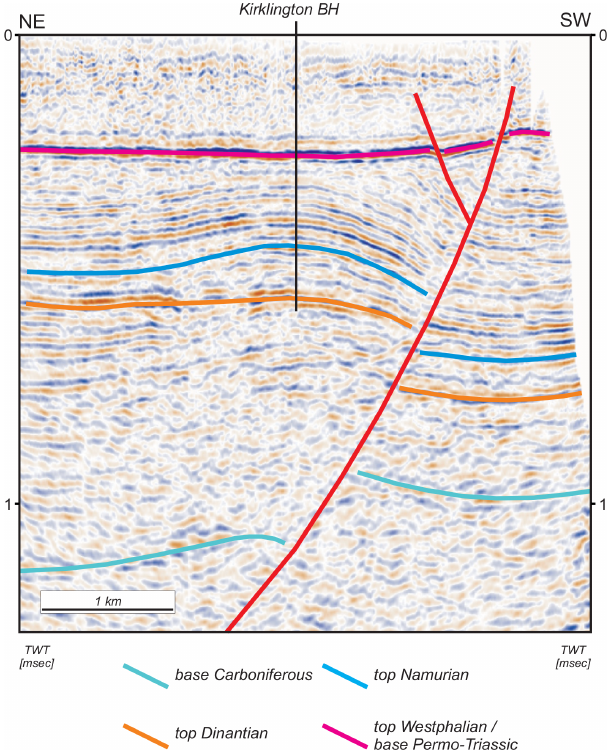
Figure 10. Interpreted seismic profile across the Eakring anticline located approximately 150km towards the north from the Variscan orogenic front in the southern UK (based on Chadwick and Evans,